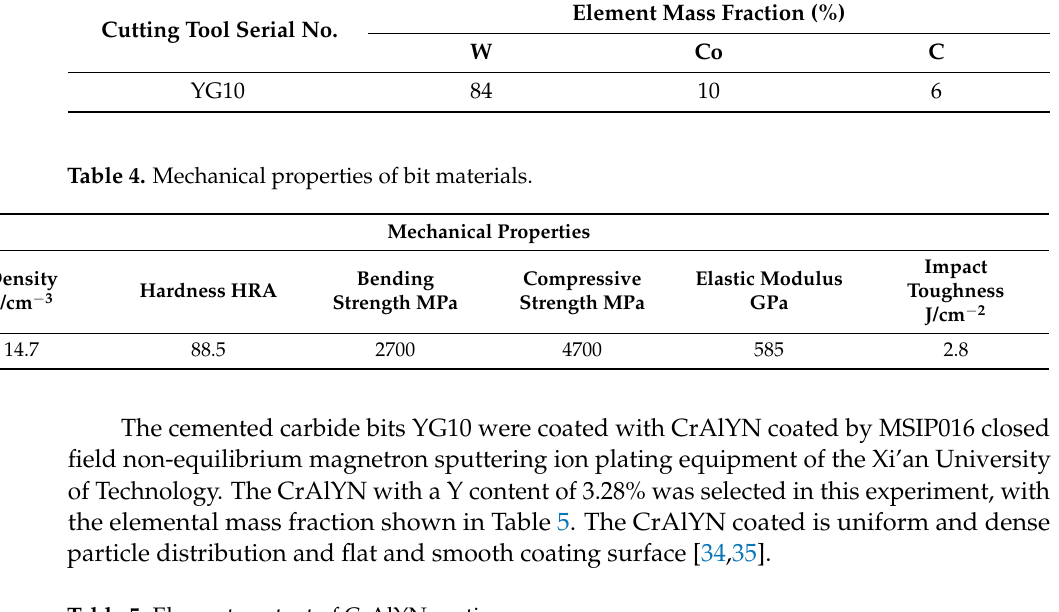
Table 5. Element content of CrAlYN